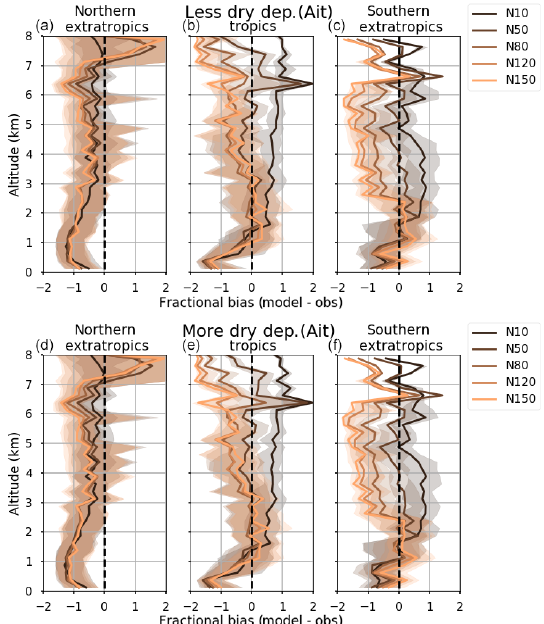
Figure C3. The vertical profile of fractional bias in modelled aerosol number at different size cut-offs for measurements in the northern extratropics (a) , the tropics (b) and the southern extratropics (c) with reduced (by a factor of 0.5) and increased (by a factor of 2) dry deposition in the Aitken